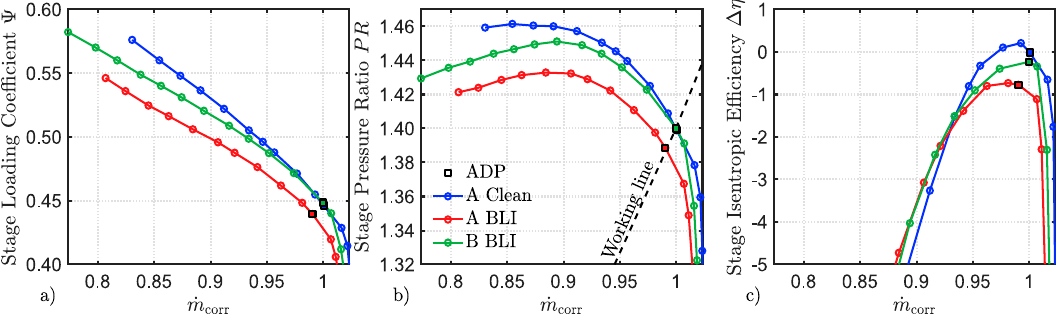
Figure 12. Effect of fuselage BLI on Fan A and Fan B at 100% corrected speed and cruise conditions: ( a ) stage loading coefficient, ( b ) stage pressure ratio, ( c ) stage isentropic efficiency (%).